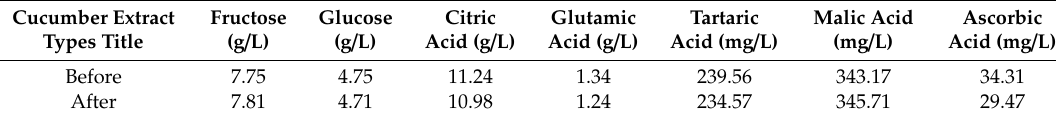
Table 3. Organic contents in cucumber extract before and after pasteurization at 90 ◦ C for 5